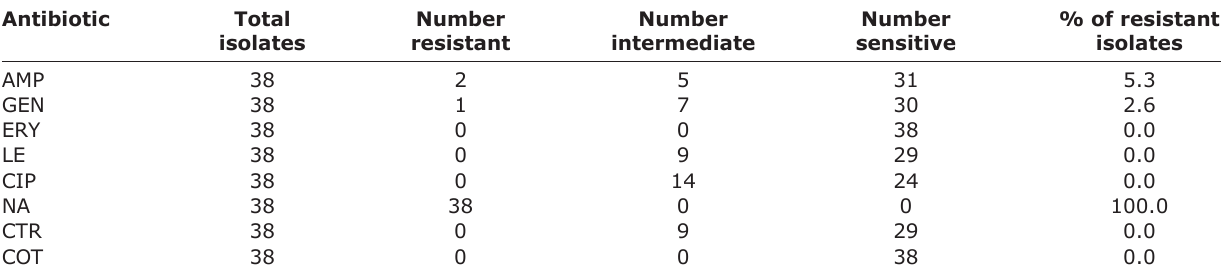
Table-4: Antibiotic sensitivity pattern of the obtained thermophilic Campylobacter isolates. Antibiotic